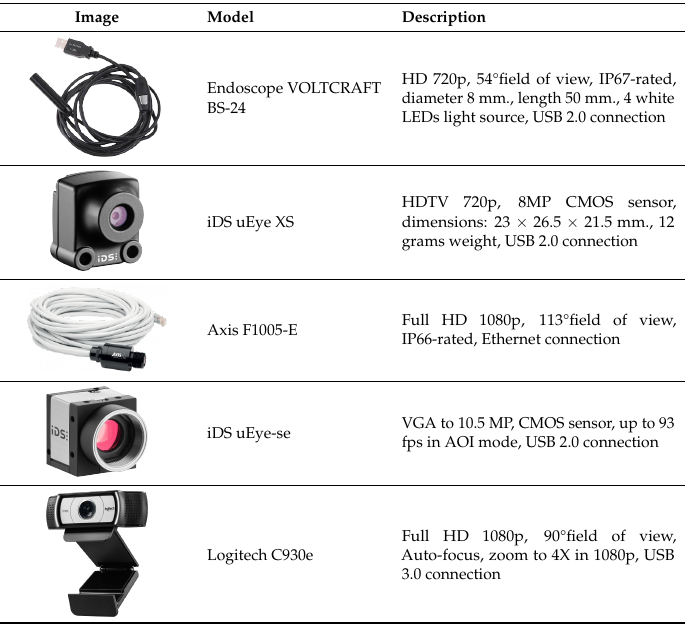
Table 1. Specifications of the Used Cameras for System